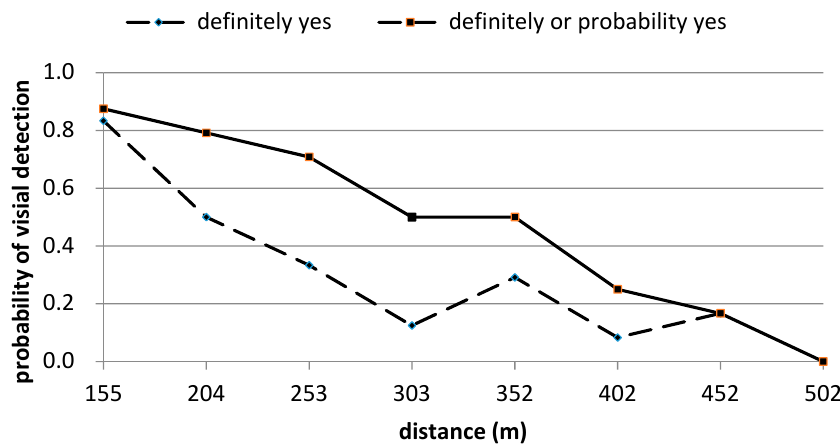
Figure 4. Probability of visual detection of the drone with the protector.